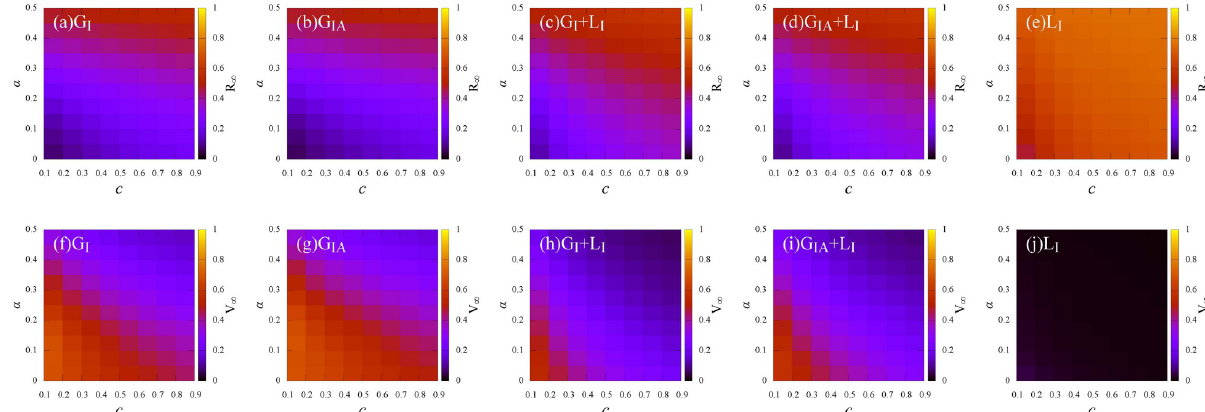
Fig 9. Effects of failure rate of vaccine ( α ) and cost ( c ) under different information sources. (a)—(e): R 1 , (f)—(j): V 1 . (a) and (f): Global information about infected individuals ( G I ); (b) and (g): Global information about infected and asymptomatic individuals ( G IA ); (c) and (h): Global information about infected individuals and local information about infected individuals ( G asymptomatic individuals combined with local information about infected individuals ( G IA + L I ); (e) and (j): Local information about infected ). Here, the infection rate λ = individuals ( L I